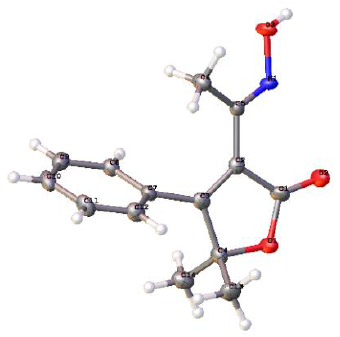
Figure 1. ORTEP drawing of compound IV-6.